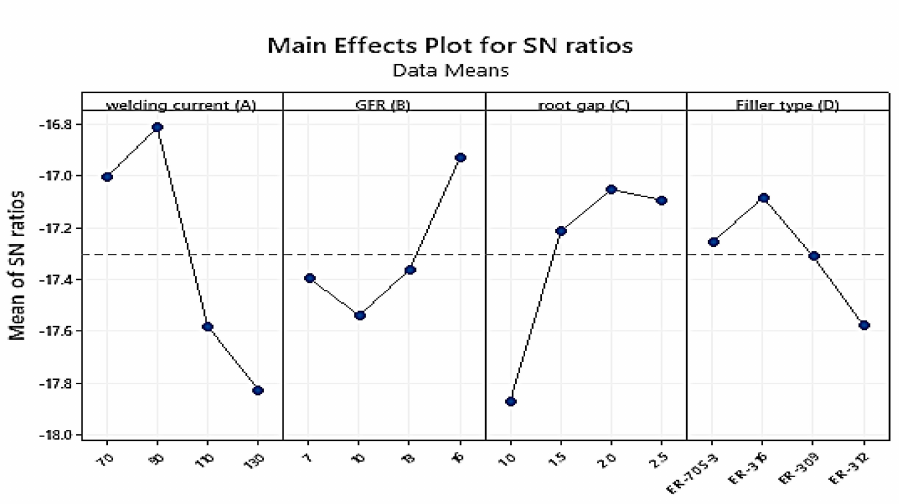
Figure 22. Main effect plot for S/N ratios of Bead